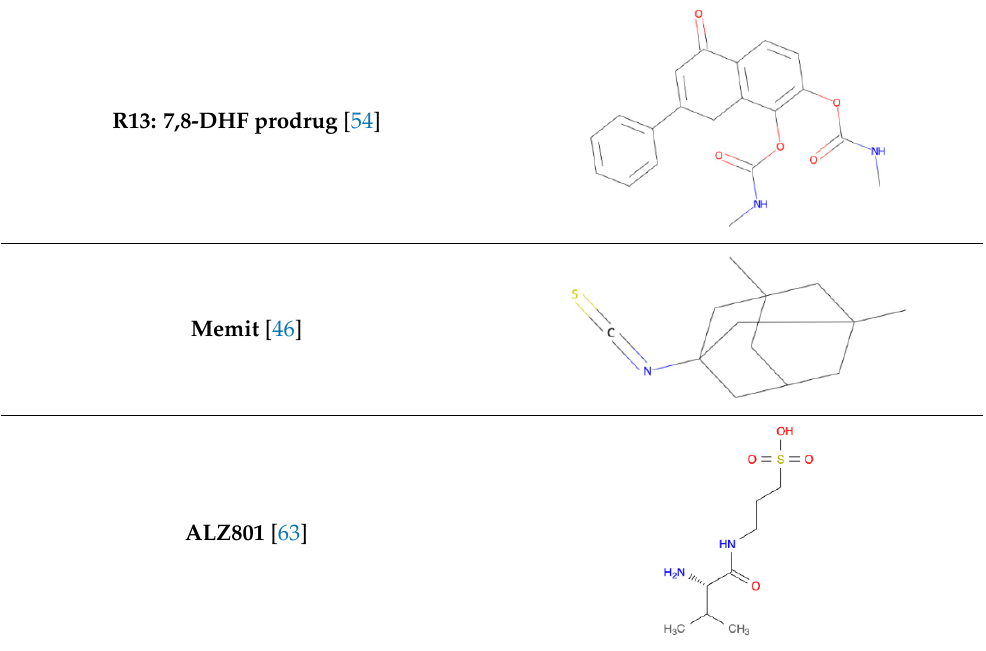
Table 1. Structures of the selected prodrugs that were developed for AD therapy.